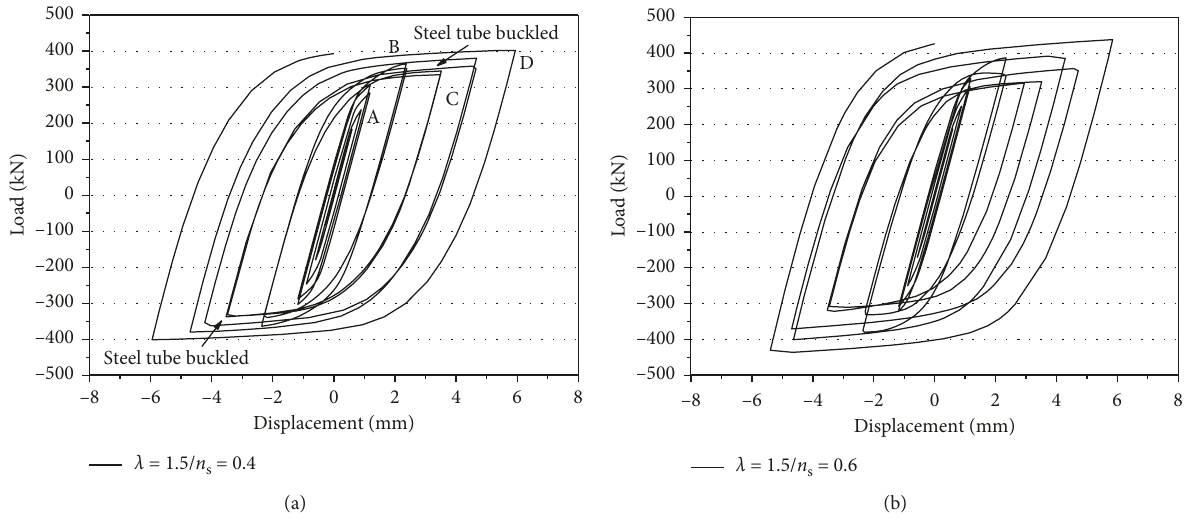
Figure 18: Hysteretic curves of the ISSCC columns. (a) n